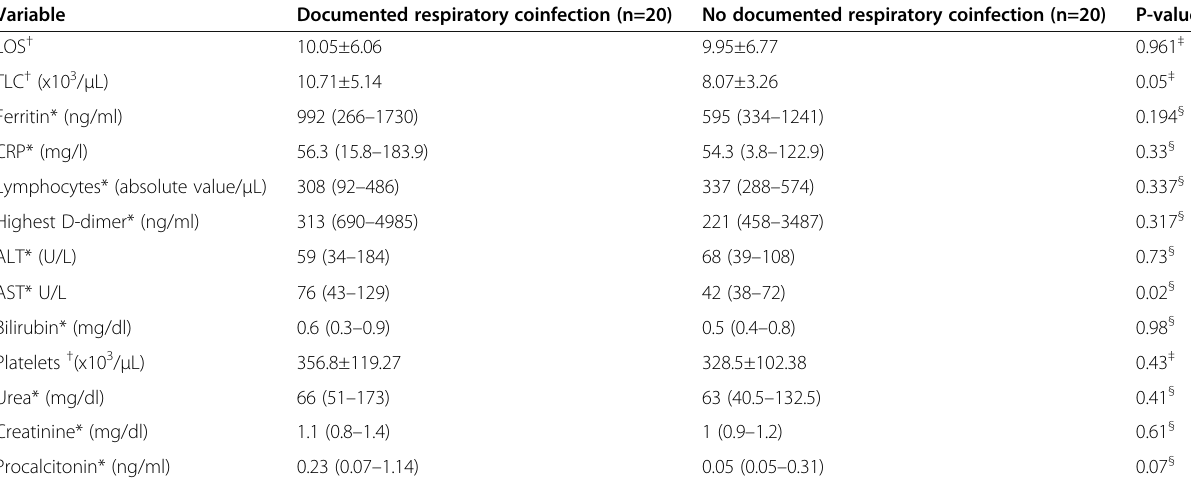
Table 4 Comparison between patients with documented respiratory coinfection versus patients without regarding LOS and laboratory